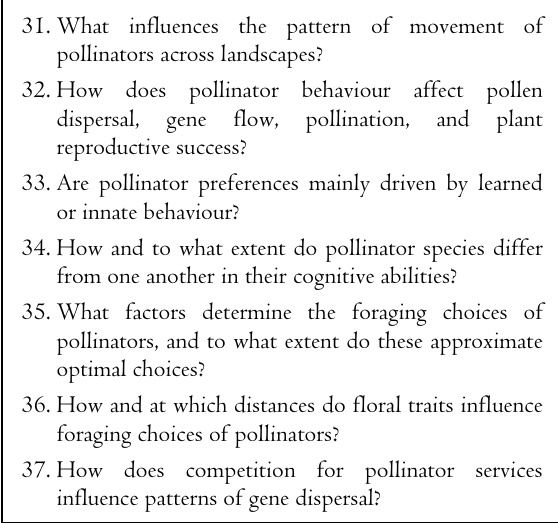
Box 5: Questions on interactions of plants, pollinators and floral antagonists